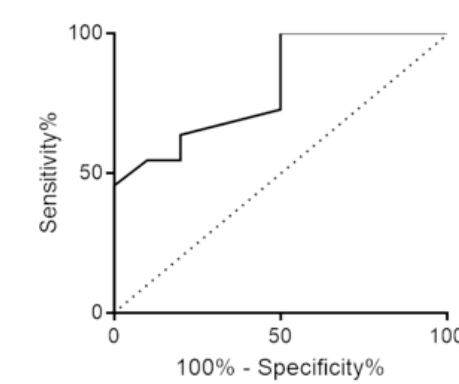
Figure 6. Pilot study 1. Performance of the MT device as a tester. ( A ) Correlation of success rate relative to the MT device with previous recent experience with micropipetting in the last 6 months ( n = 21, * p > 0.05, Wilcoxon correlation test); ( B ) Correlation of success rate relative to the MT device with the level of experience in handling microfluidic supports, as measured with OrganoPlate ® 2-lane ( n = 21, ** p < 0.05, Spearman correlation test). ( C ) The receiver operating characteristic (ROC) curve for the prediction ability of the MT device about the performance in handling microfluidic supports ( n = 21, * p = 0.0167, good performers n = 10, bed performers n = 11).